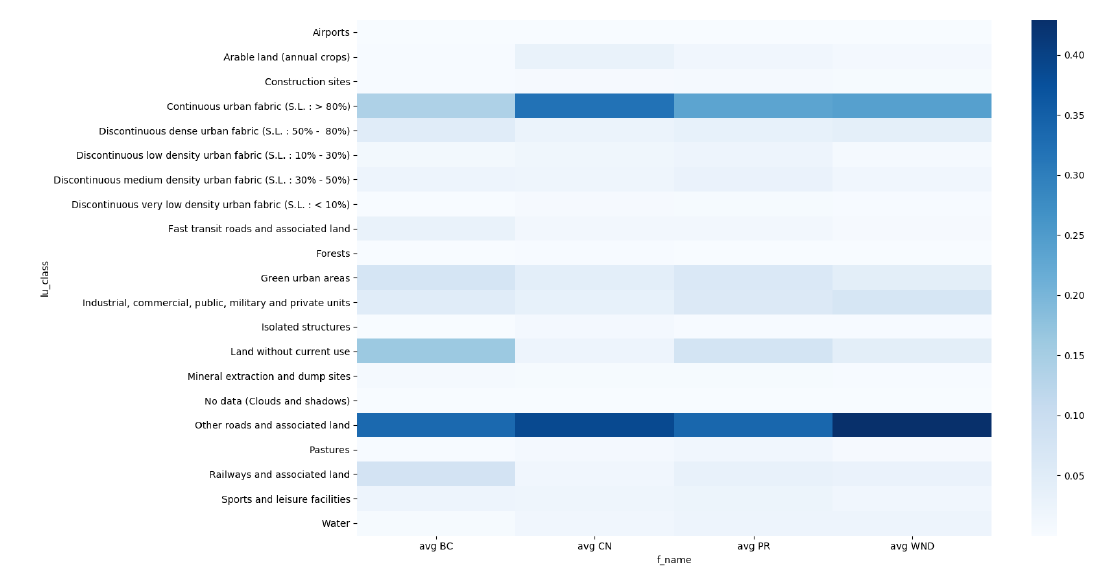
Figure 8. Importance of land use classes for predicting graph based properties.